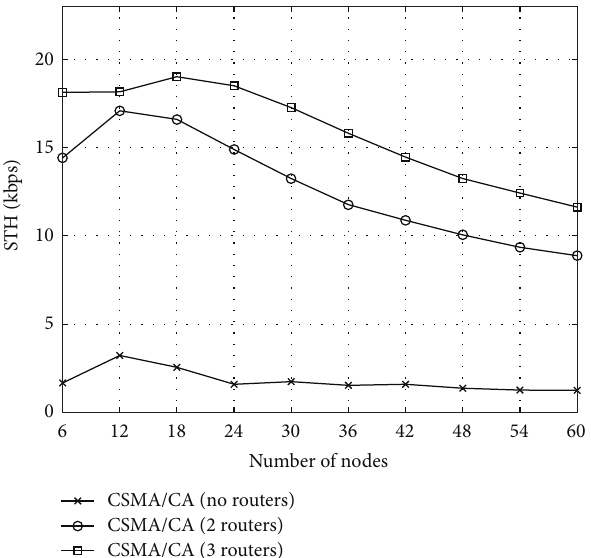
F 8: Simulated STH for different network